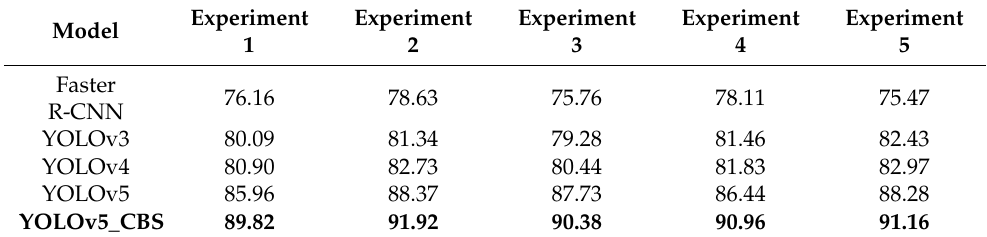
Table 3. Average precision (%) of compared models on private dataset.